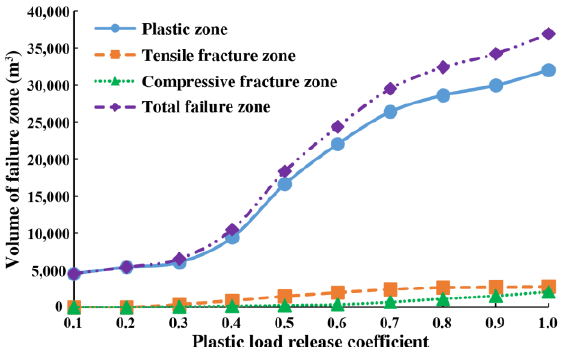
Figure 7. Surrounding rock failure zone variation with plastic load release coefficient of type V surrounding rock.